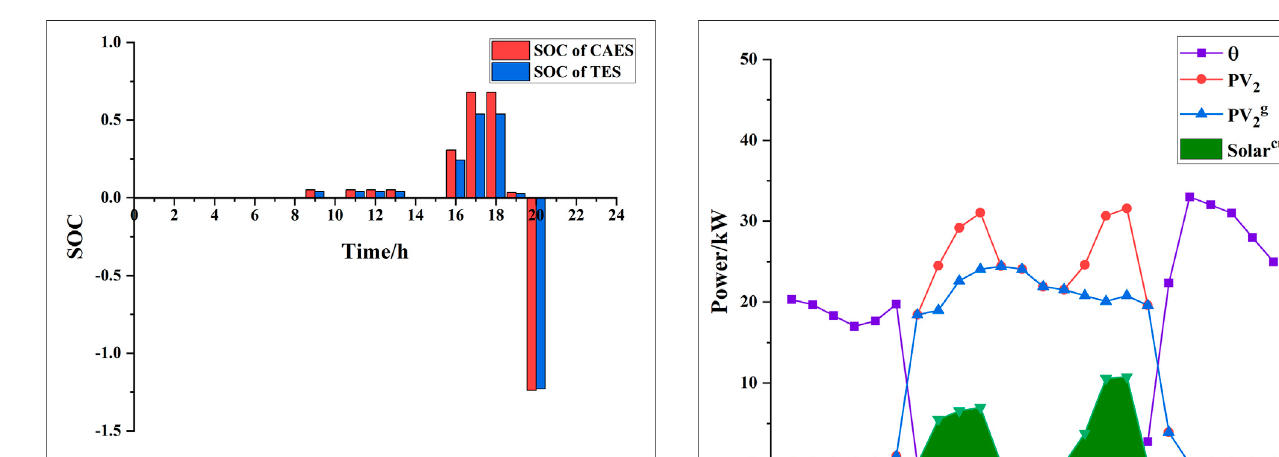
FIGURE 8 | SOC of HA-CAES hub and TES.